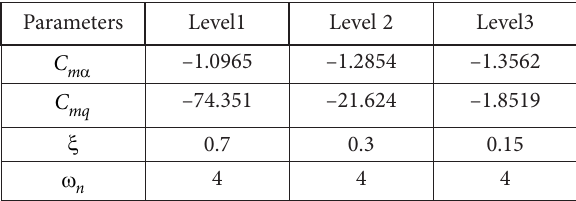
fixed natural frequency; variable